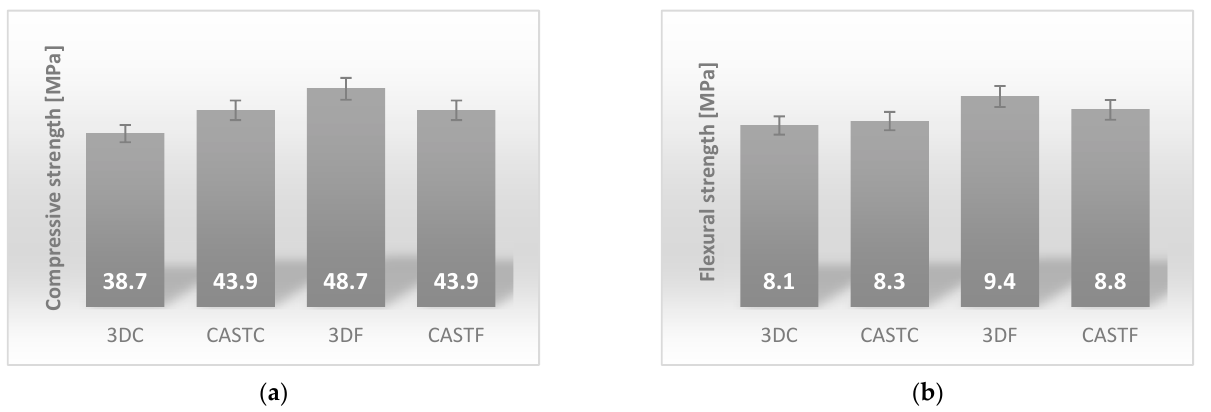
Figure 1. Mechanical properties: ( a ) compressive strength; ( b ) flexural strength.